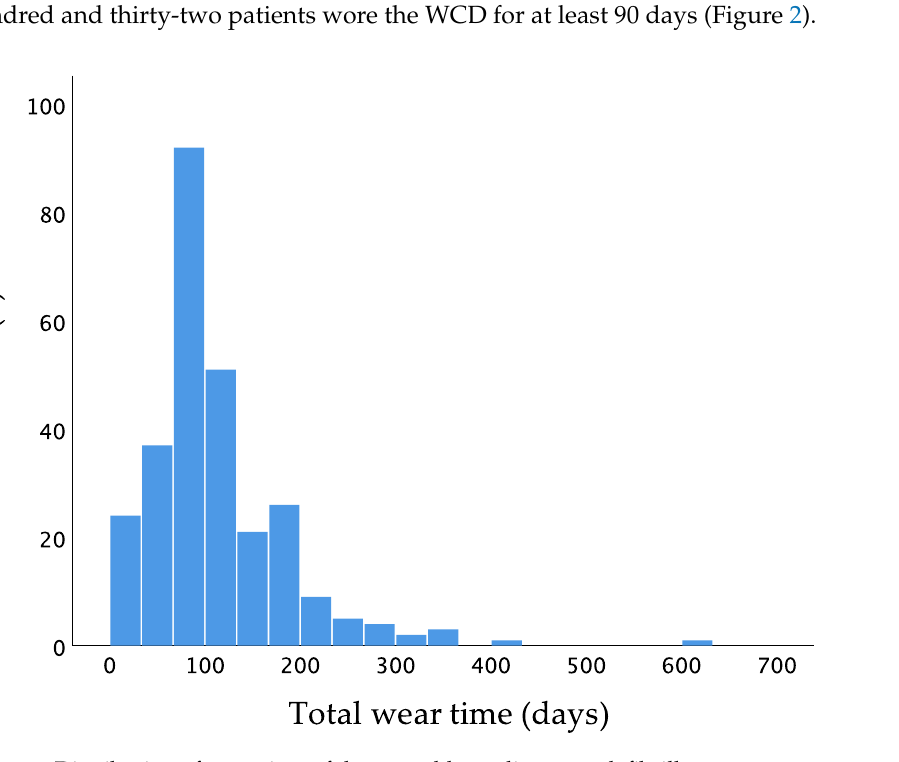
Figure 2. Distribution of wear time of the wearable cardioverter – defibrillator.